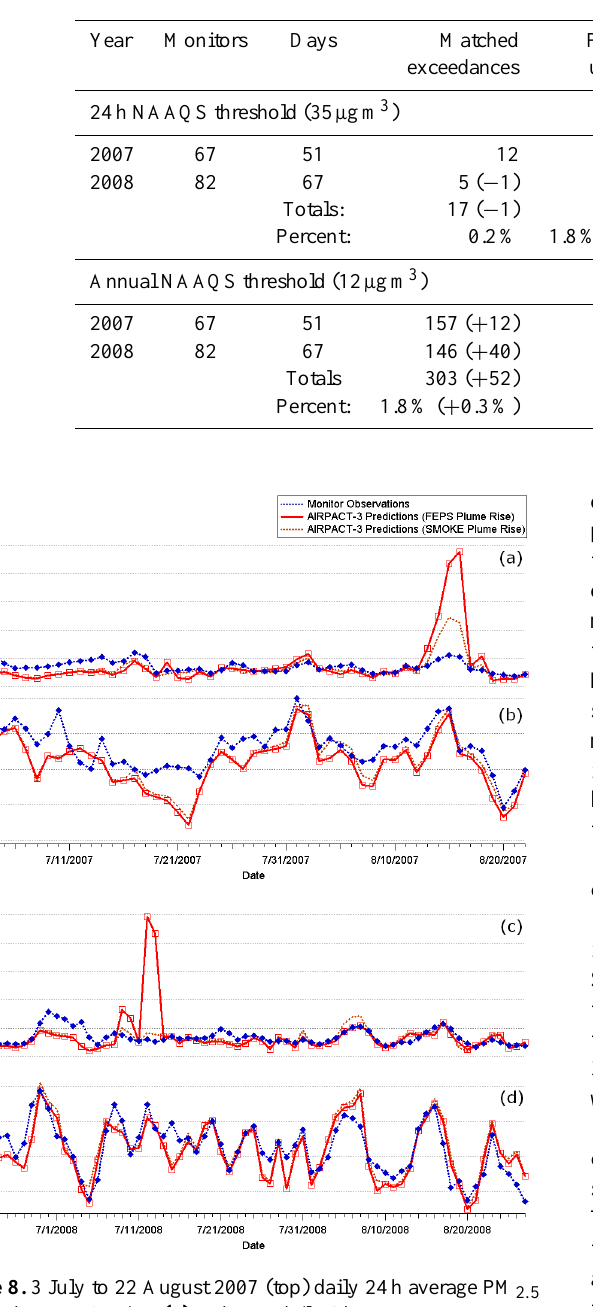
Table 6. PM 2 . 5 National Ambient Air Quality Standards summary for both 2007 and 2008 fire periods analyzed per site per day for the FEPS plume-rise scenario (change due to SMOKE plume-rise scenario shown in parentheses).